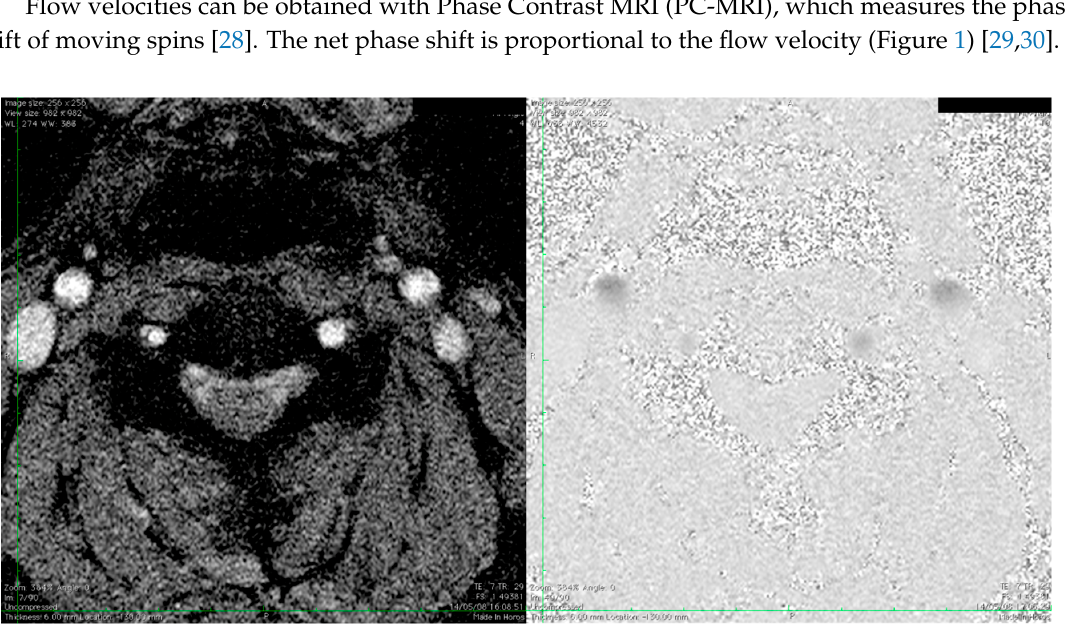
Figure 1. The left image shows a time-of-flight image of the neck in the transverse scan plane. The image is used for identifying and marking the carotid arteries for velocity estimation with phase contrast MRI. The right image shows the phase contrast image using a through-plane sequence. Images were provided by co-author Kristoffer Lindskov